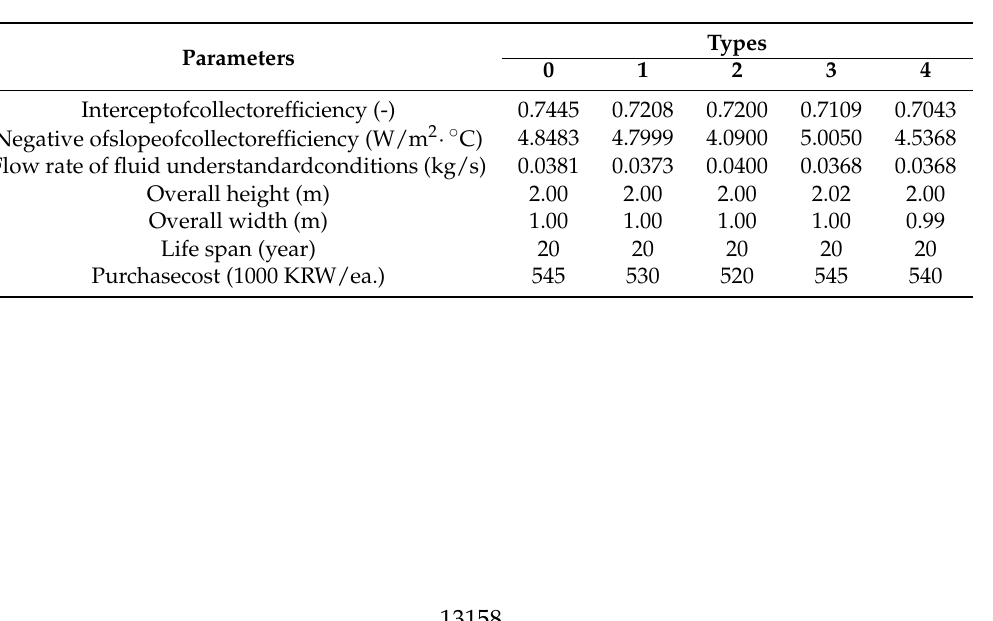
Table A1. Technical and economic parameters of solar collectors for case